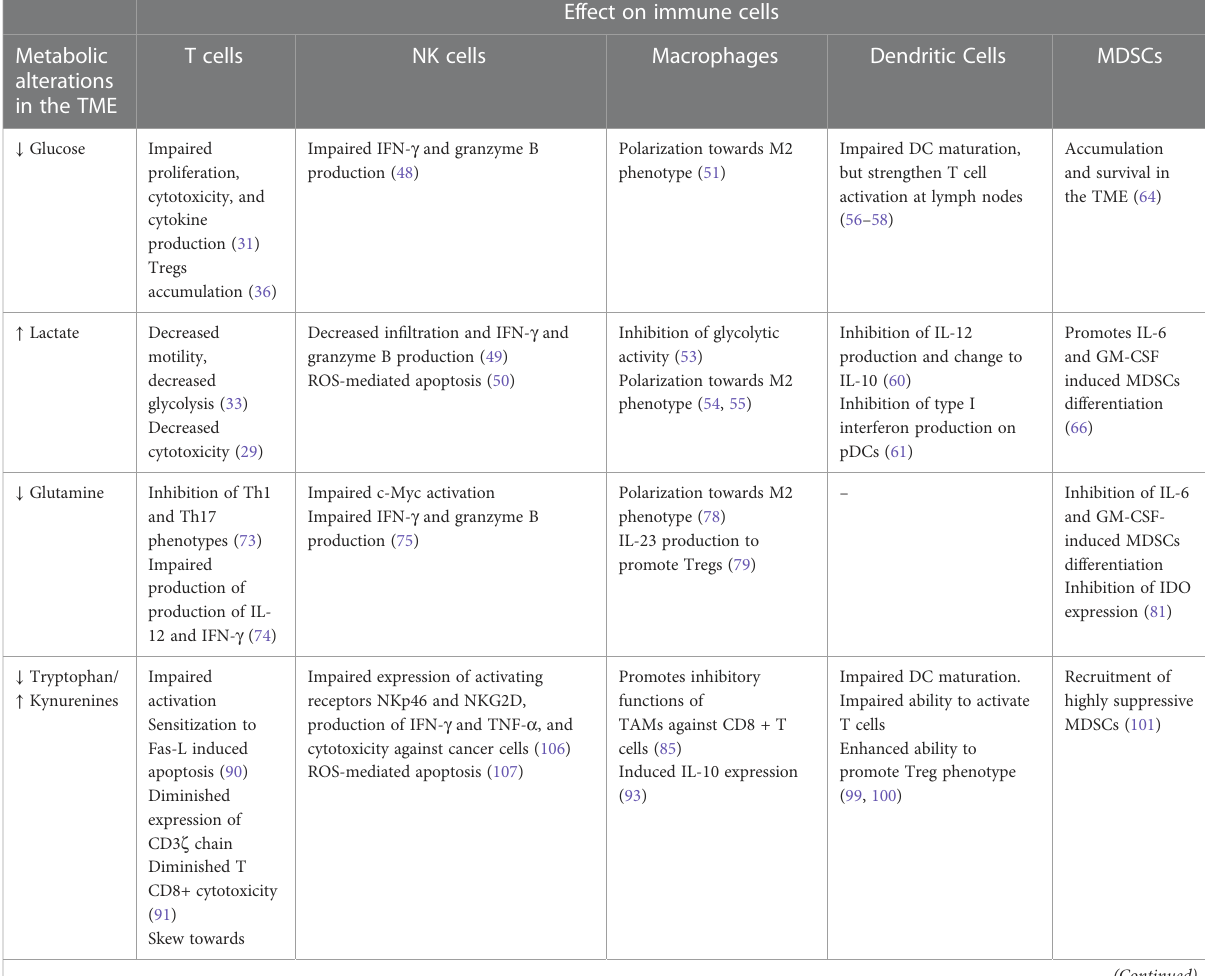
TABLE 1 Main alterations of tumor-in fi ltrating cells by metabolic